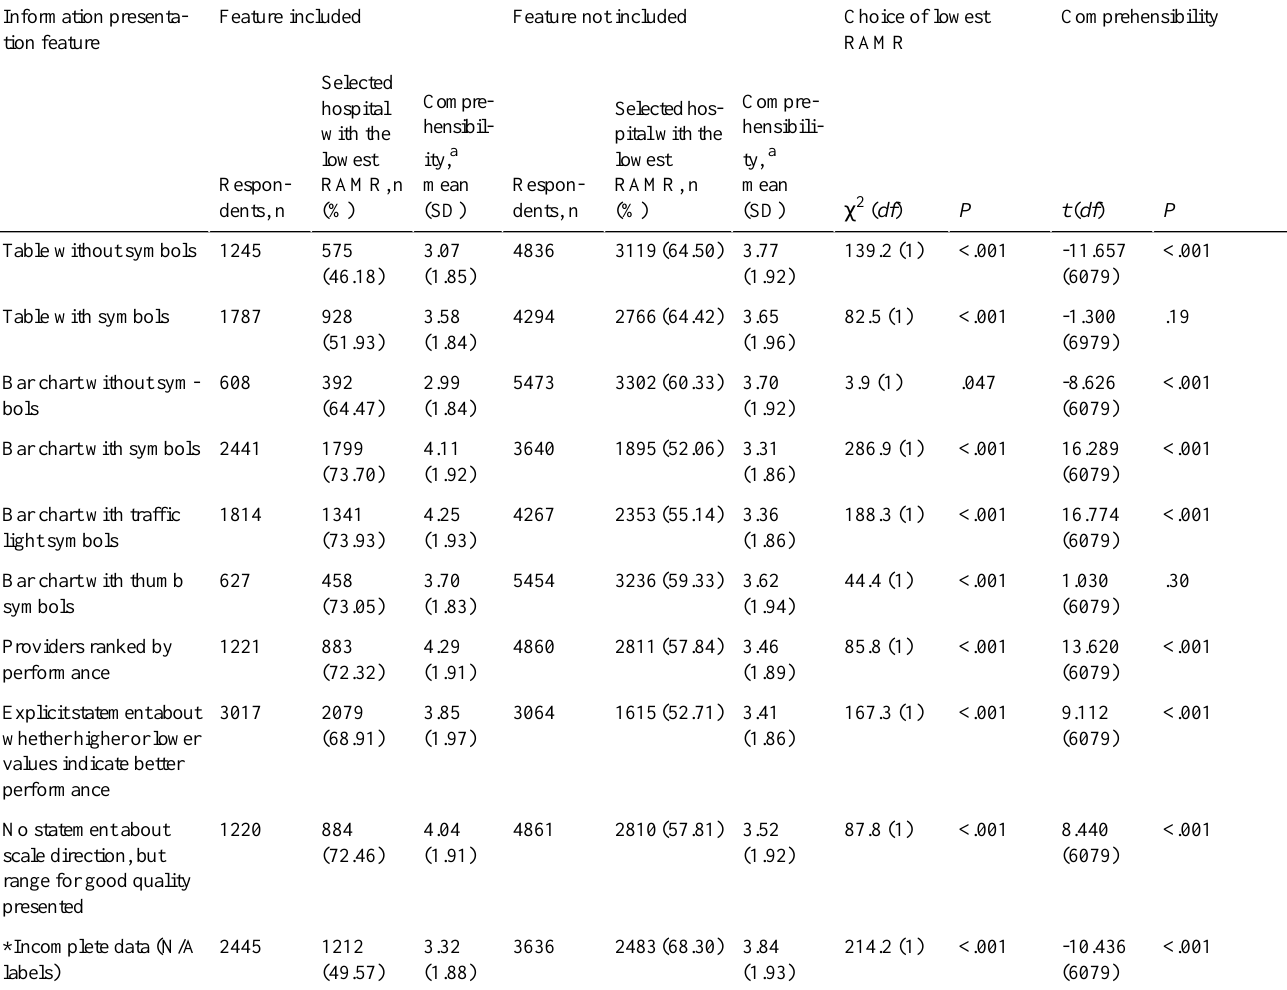
ComprehensibilityChoice of lowest RAMRFeature not includedFeature includedInformation presenta-